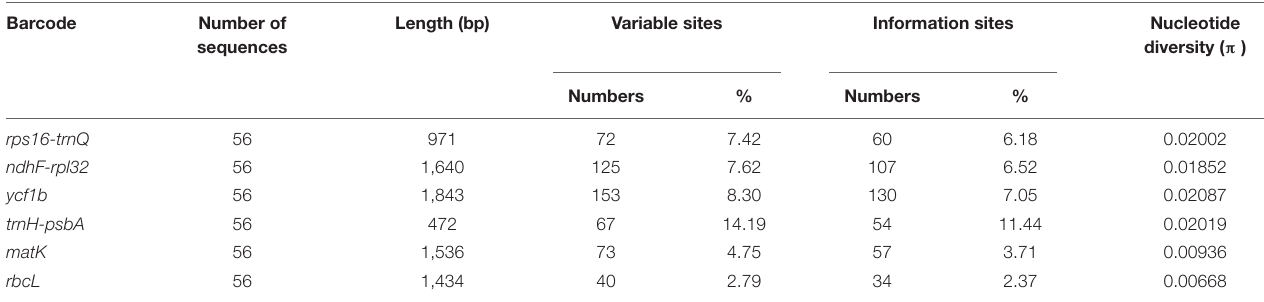
FIGURE 2 | Hypervariable regions in the Arnebia chloroplast genome. Window length: 800 bp; step size: 100 bp. Three regions with the highest π values were marked. x -axis: position of the midpoint of a window; y -axis: nucleotide diversity of each window. TABLE 3 | Three hypervariable regions and the universal markers of chloroplast genomes of Arnebia